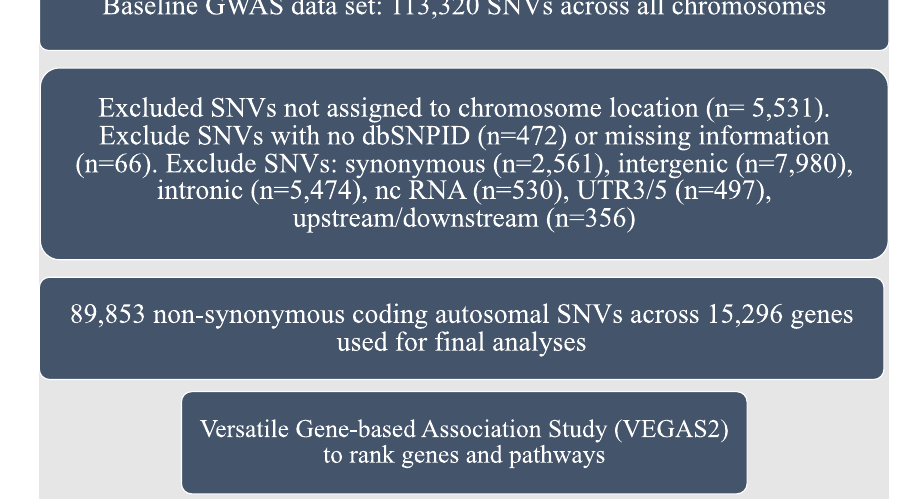
Figure 1. SNVs and corresponding genes used in final analysis (42,335 cases and 78,240 controls). SNVs single nucleotide variants, GWAS genome wide association studies, RNA ribonucleic acid, UTR untranslated